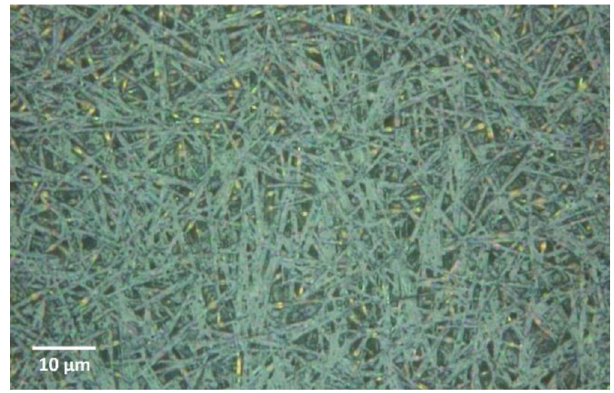
Fig. 2. Fiber-like structures observed by optical microscopy after the ultrasonic spray coating of perovskite with slow solvent evaporation.